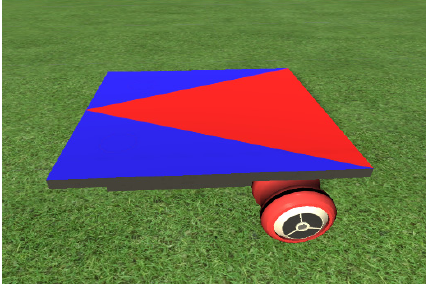
Figure 7. Ground robot, the picture on the surface of the robot was used for navigation with the help of the deep learning network.